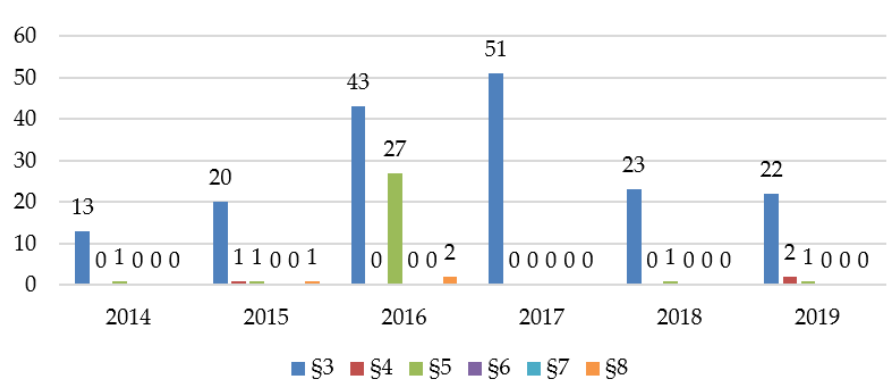
Figure 10. Comparison of the number of decisions pursuant to §3–8 Act No 220/2004 Coll. in the